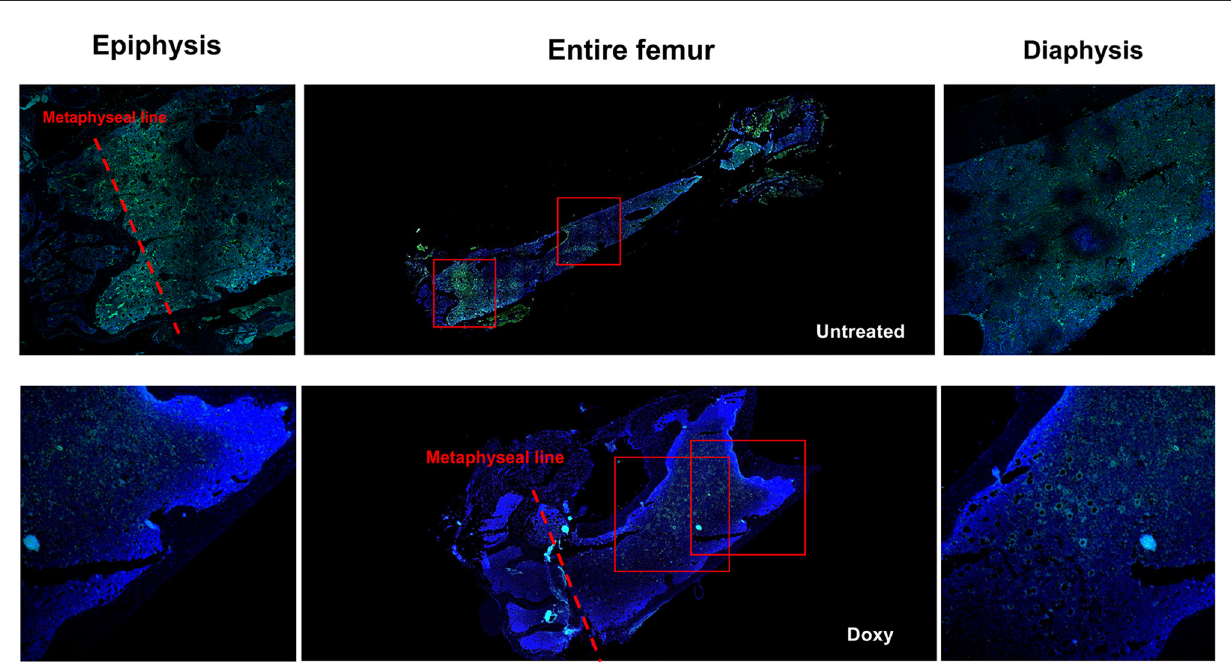
FIGURE4 Both in untreated and in Doxy-treated mice, GFP positive cells are localized in all the areas of a femur (both in the epiphysis and in the diaphysis). Reconstruction of the femur from a representative untreated and Doxy-treated mutant mouse (middle panels) and detail of the epiphysis (left panels) and of the diaphysis (right panels) of the same femur obtained by confocal microscopy. The Dapi and GFP signals are merged. The rectangles in the middle panels indicate the areas shown at greater magnification in the panels on the side. Original magnification x100 and x200 for the entire femurs and their detail,